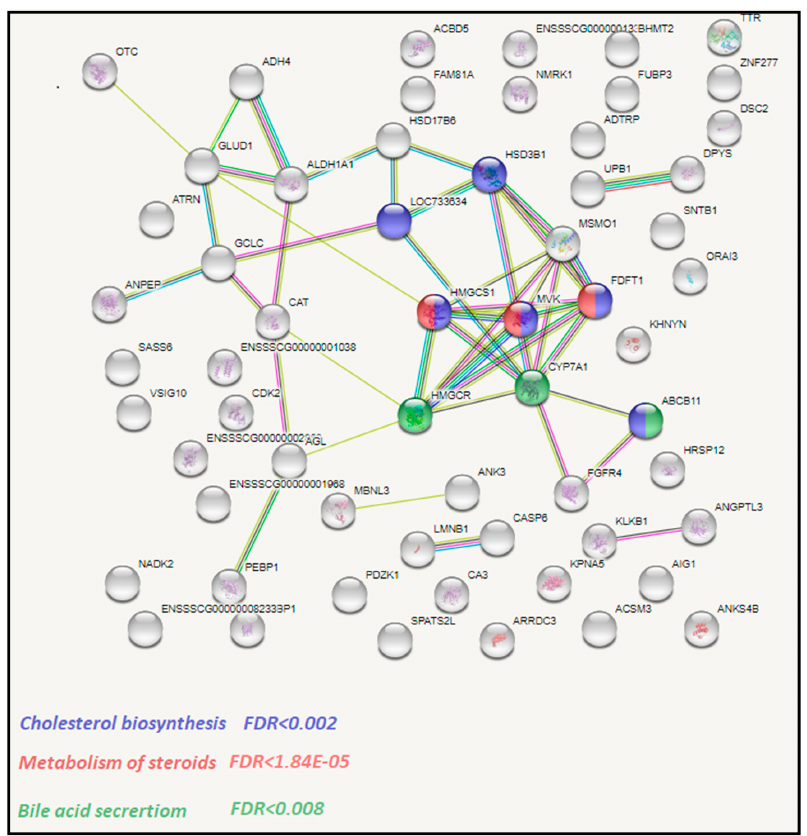
Figure 3. The network of DEGs downregulated in the beef tallow group when compared to the rapeseed oil group according to STRING software analysis.